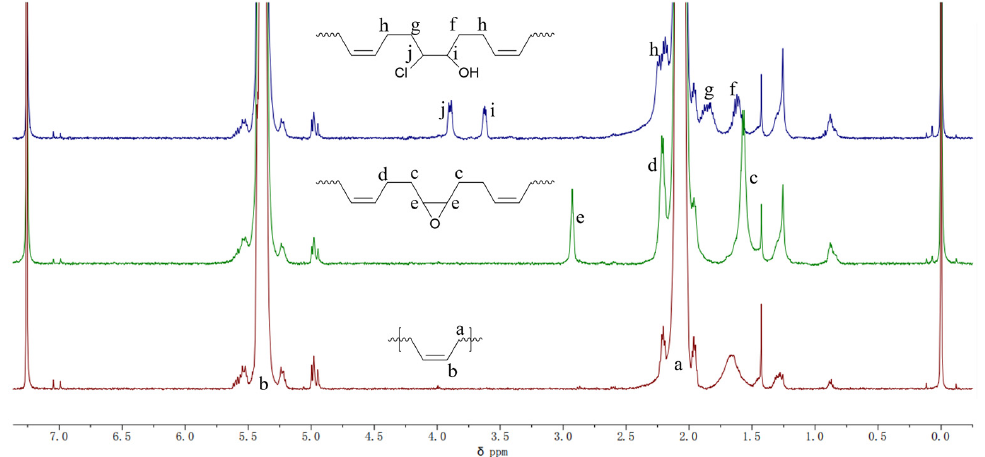
Figure 1. 1 H NMR spectra of BR with a 3 mol % degree of modification.